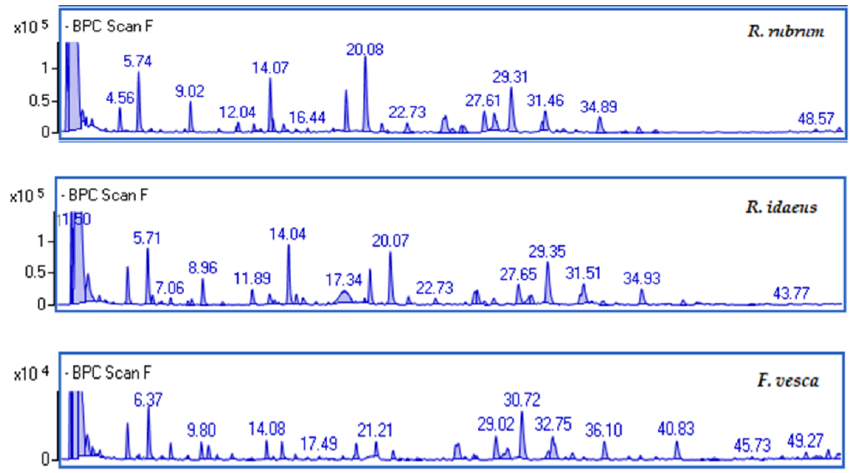
Figure 1. Representative base peak chromatograms (BPC) for R. rubrum, R. idaeus, and F. vesca. Table 1. Bioactive Compounds Detected Using UHPLC/DAD/ESI-MS in R. rubrum , R. ideaus, and F. vesca .